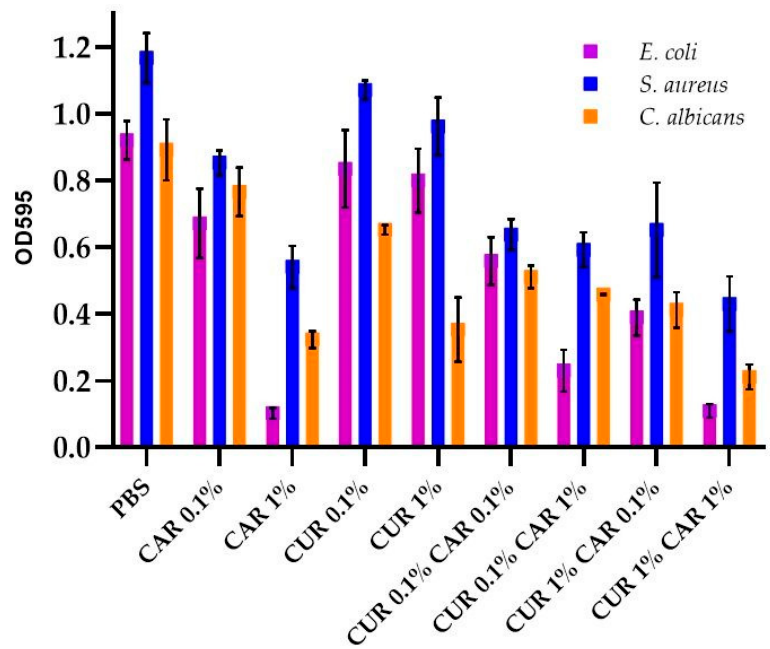
Figure 4. The effect of PBS-based neat and modified films on biofilm formation.